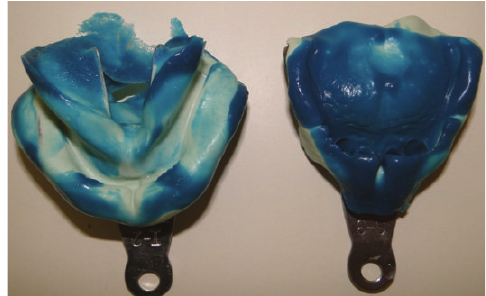
Figure 5: Silicone maxillary and mandibular impressions.